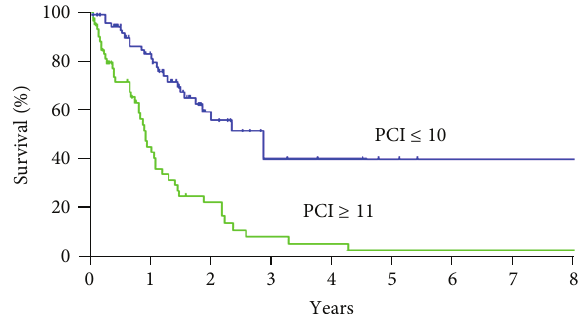
Figure 2: Survival curves of patients who underwent CCR-0 resec- tion and CCR-1 resection ( 𝜒 2 = 26.791 , 𝑃 < 0.001 ). MST and 5-year survival rate were 25.9 months and 20% in patients who underwent to CCR-0 resection, but these in patients who underwent who CCR- 1 resection were 8.0 months and 9.9%, respectively.